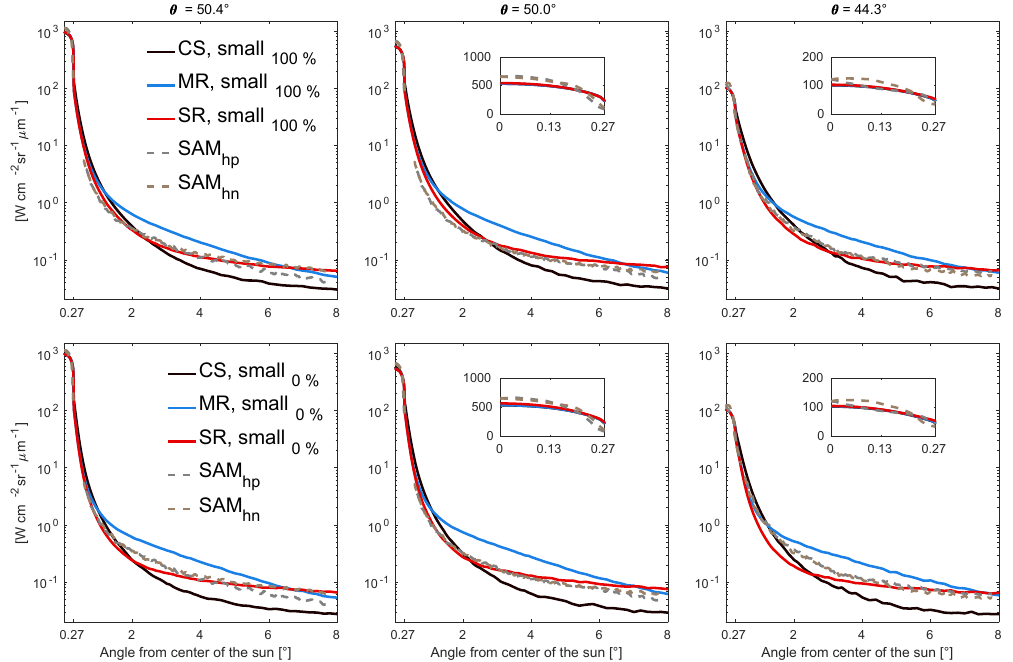
Figure 14. Comparison of SAM measured (hp and hn for the horizontal profiles to the right and left from the center of the sun) and simulated radiances at three measurement times during flight B. For the simulations, the large B distribution with 100 and 0% of measured concentration of small ice crystals is used with τ and θ values listed in Table 5. Smooth (CS) and rough (MR and SR) ice crystals are considered.